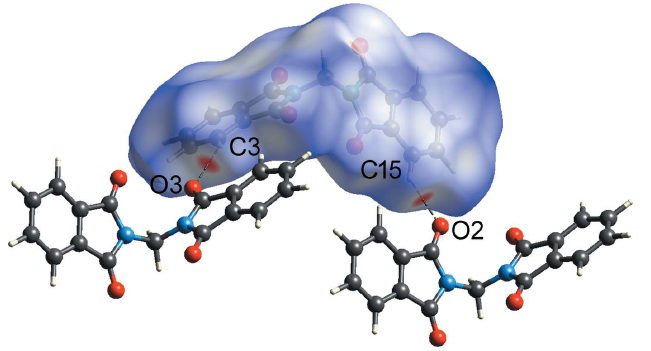
Figure 5 The Hirshfeld surface mapped over d norm for the molecule in the asymmetric unit of 1 (cid:3) hydrogen-bonded to two neighbouring molecules.